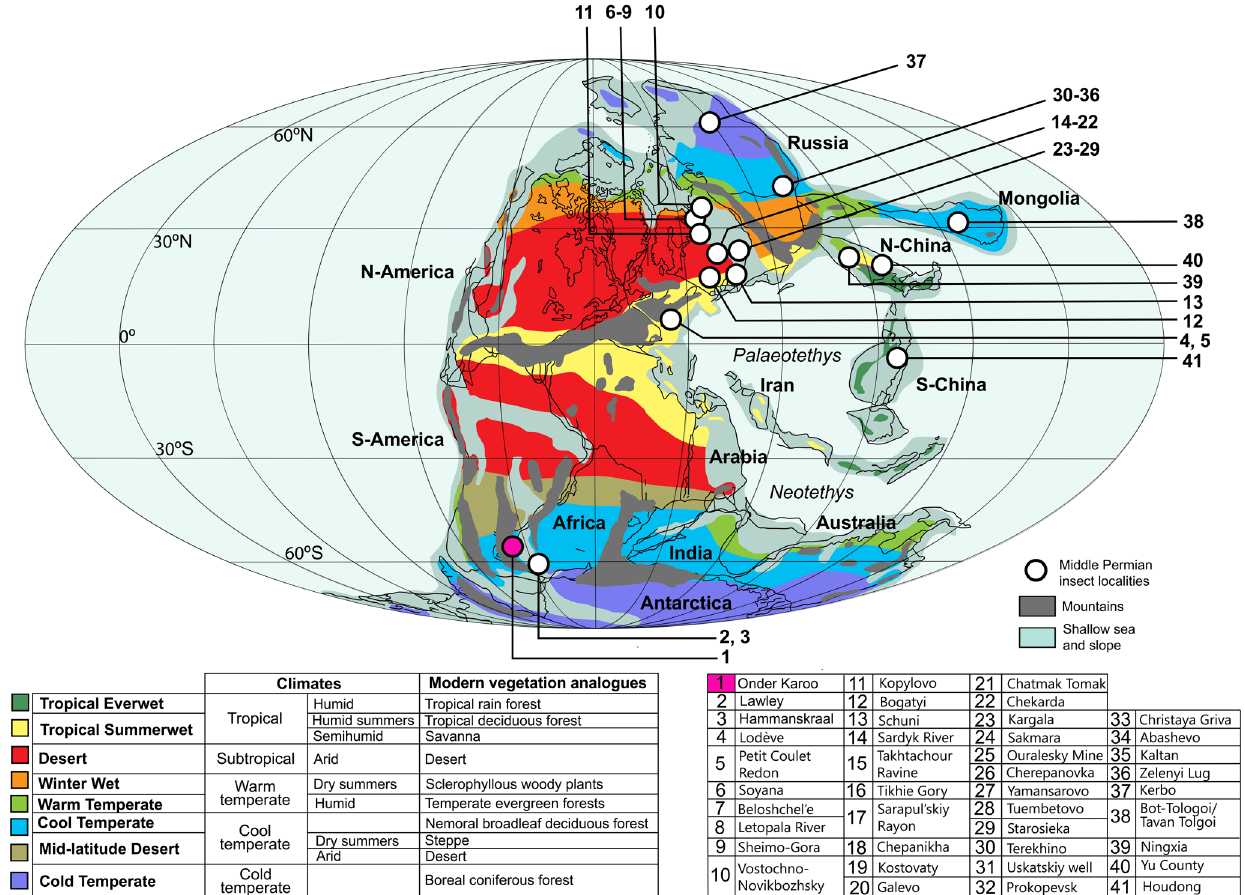
Fig. 1 Locations of middle Permian fossil insect discoveries and climatic zones for the Wordian of Pangea. Wordian climate zones as inferred by Rees et al. 94 ; colour-coded to analogous modern vegetation types developed by Walter 95 . The map of Pangea is a compilation based on Lucas et al. 96 and Scotese 97 . Pink dot = Onder Karoo locality. See Supplementary Note 1, and Supplementary Fig. 1 and Supplementary Table 1 for current locations and names of middle Permian insect sites, and relevant